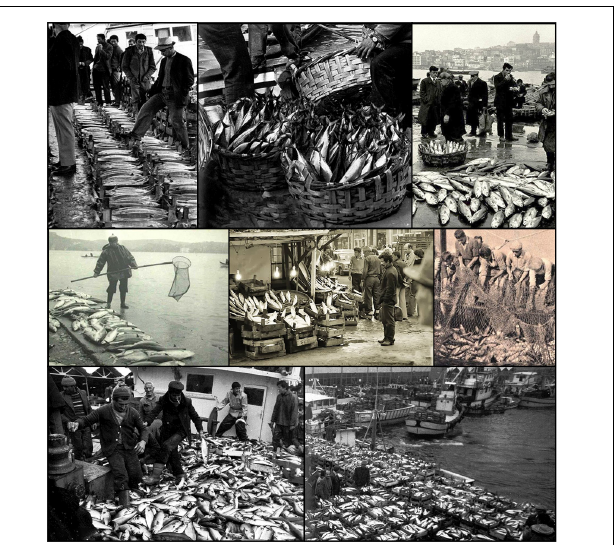
FIGURE 4 | Photos of larger bluefish ‘ kofana ’ and bonito ‘ torik ’ harvest in Istanbul between 1950 and 1975 (Can, 2013).